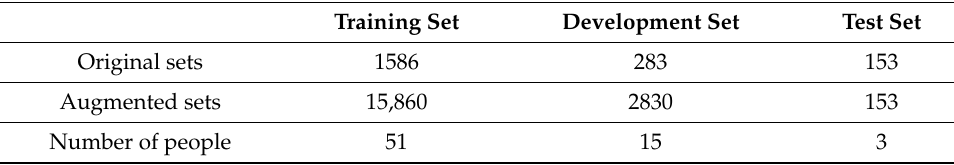
Table 2. Number of image frames in each learning